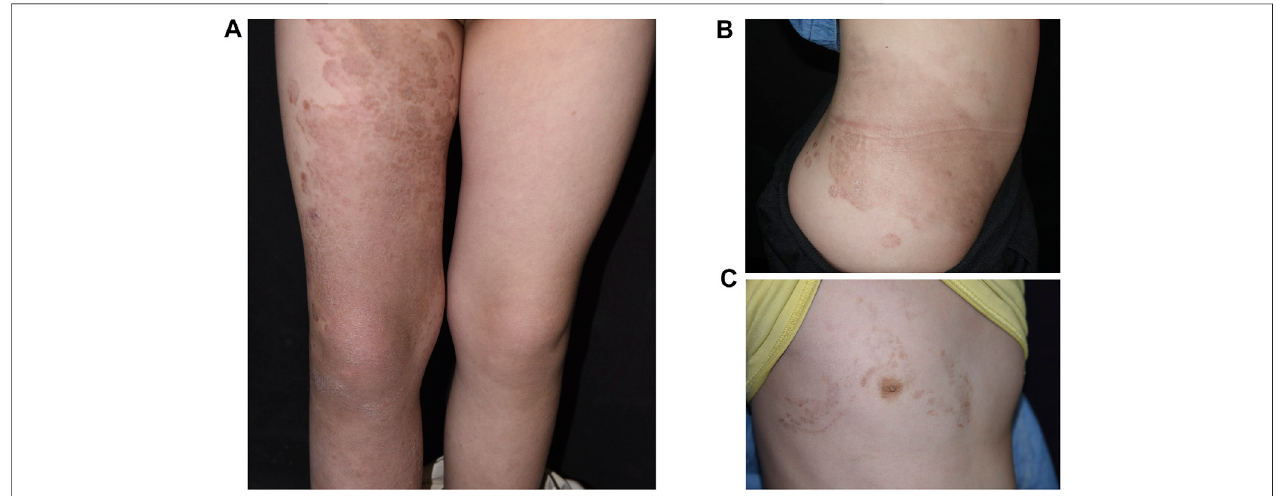
FIGURE1| Clinicalimagesshowingdemarcated,annular,red-brown plaquesovertheextensor sideofright lowerlimb (A) ,lumbarregion (B) ,and rightsideofthe patient ’ s chest (C) .